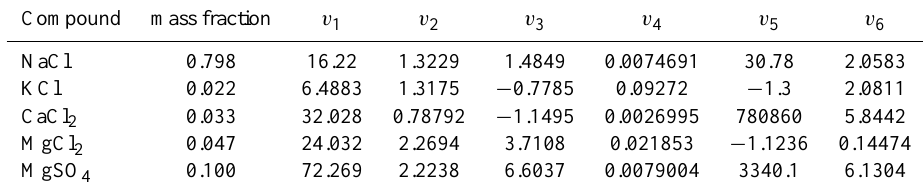
Table A2. Parameters for calculating solute viscosity, and mass fraction of each solute (as a proportion of total salinity) for Eqs. (30) and